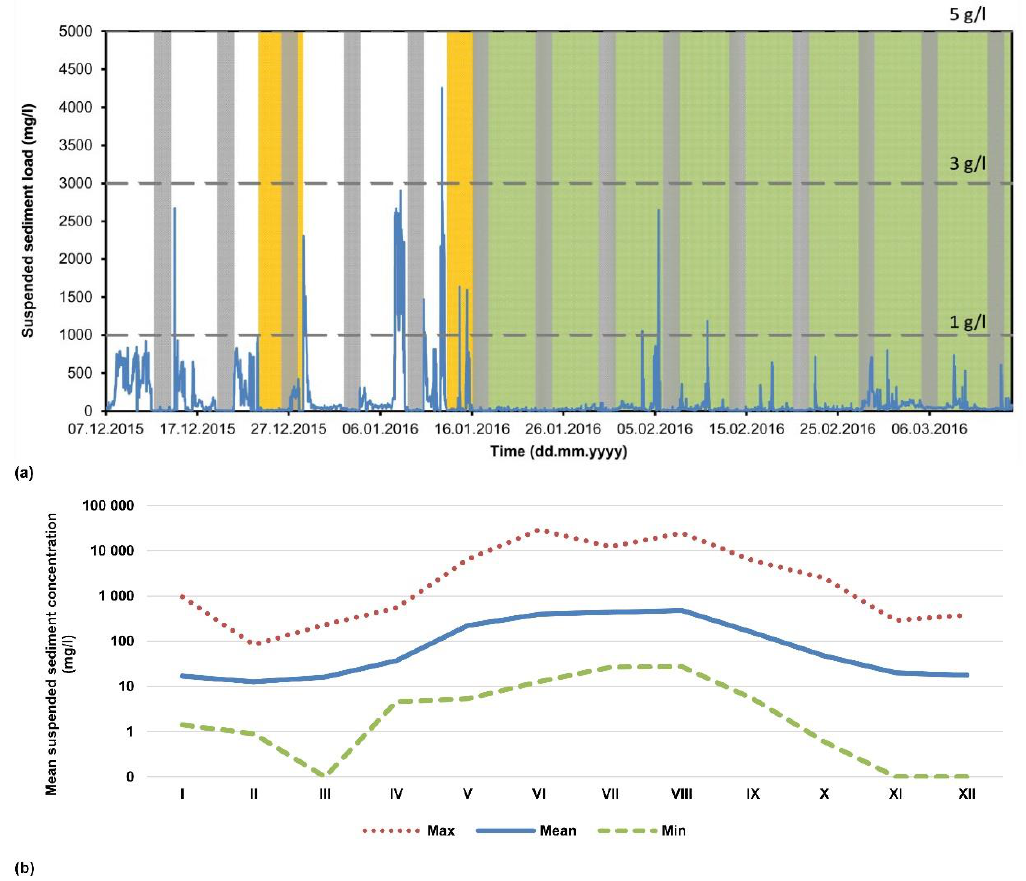
Figure 3. ( a ) Continuous records of suspended sediment concentration at sampling station 1 (Prutz) (immediately downstream of the tailrace channel of the HPP Kaunertal) (blue line); yellow bars = stop of the continuous drawdown via the penstock and; green bars = cleaning period and ( b ) minimum, mean, and maximum suspended sediment concentration per month at gauging station Innsbruck for monitoring period 2005 – 2015 (database: hydrological survey Tirol); y-axis: log-scale.